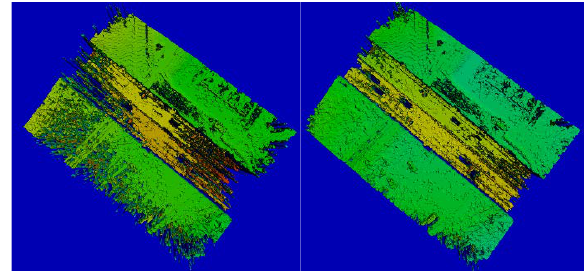
Figure 3. UAV Stereo DSM (Left: using initial EO parameters, Right: using adjusted EO parameters)